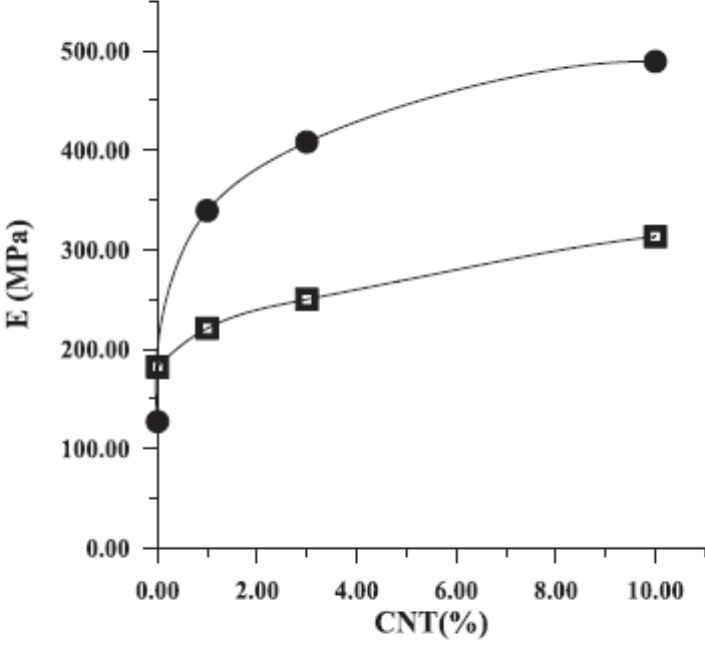
Figure 50. The elastic moduli for samples quenched at 25 °C ( ● ) and at 100 °C ( ◘ ). Reproduced with permission from ref.